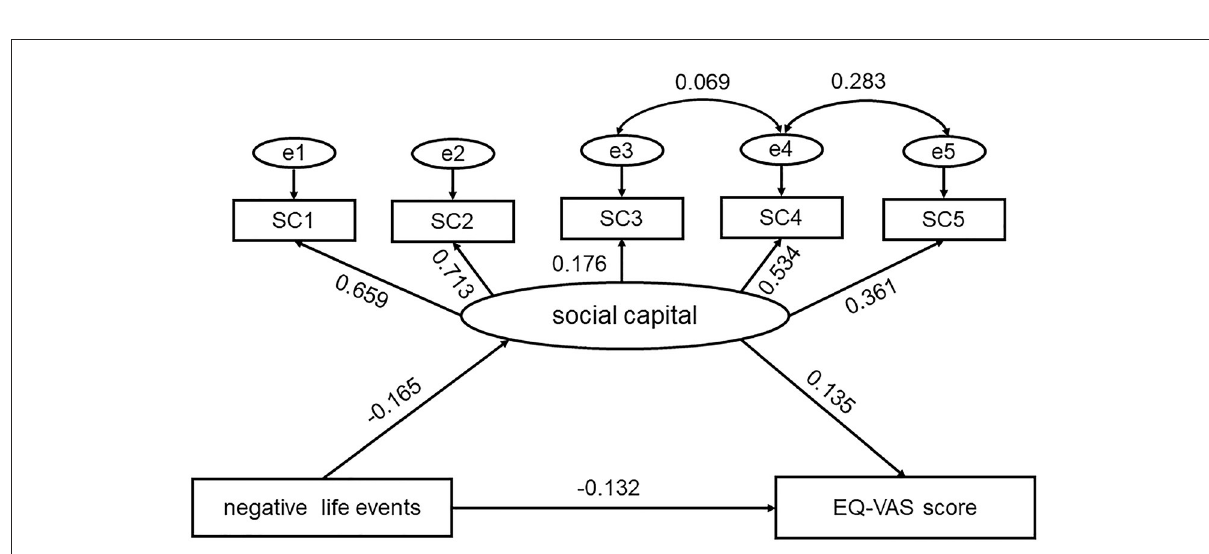
FIGURE4 Conceptual model of the impact of social capital and negative life events on EQ-VAS score. SC1 ∼ SC5 represent five items in the brief social capital